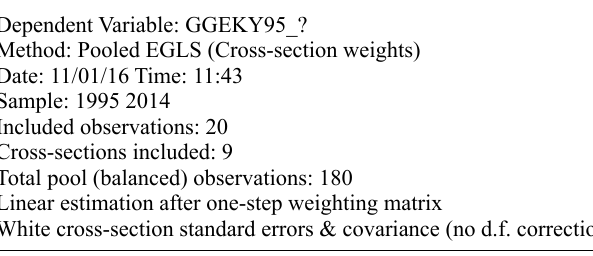
Table 5. Regression parameter estimates for the extended model of developed